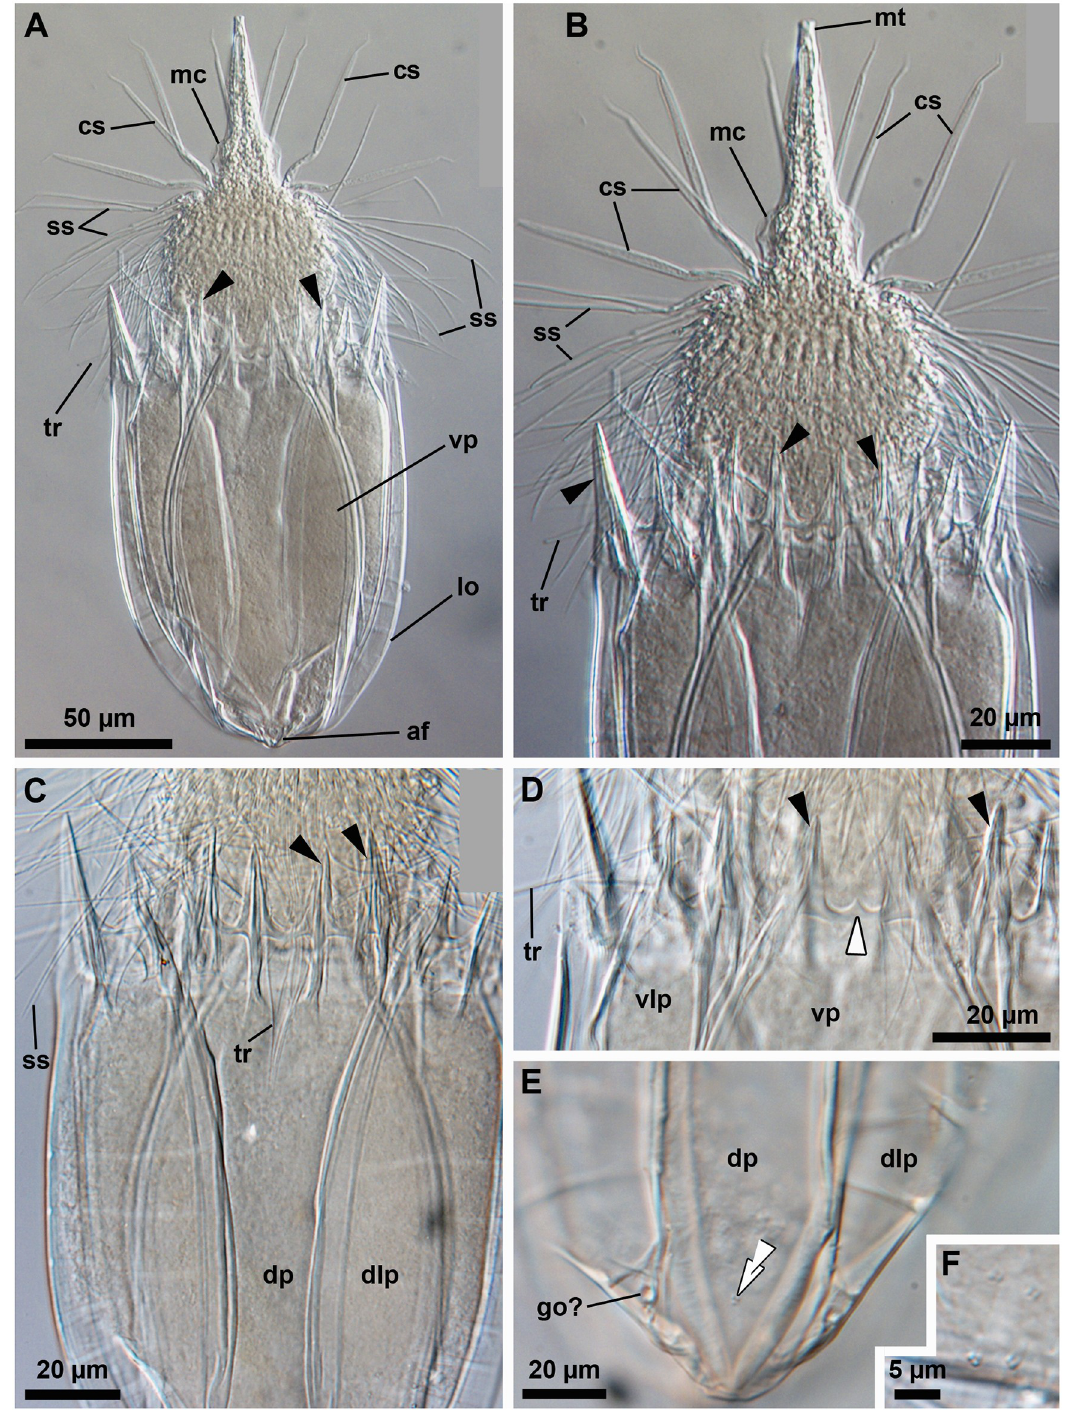
Fig 11. Light micrographs of the allotypic adult female of Nanaloricus mathildeae sp. nov. Anterior faces up in all aspects. (A) Ventral view of the extended specimen. Note that the mouth tube is not fully extended. Black arrowheads indicate anterior spikes. (B) Close-up of anterior body half, ventral view. (C) Introvert, neck and anterior region of the abdomen, dorsal view. (D) Close-up of anterior spikes of the ventral and ventrolateral plates. White arrowhead points to the very small midventral anterior spike. (E) Close up of the posterior region of the lorica, dorsal view. Note the putative gonopores (go?) located on the posteriormost region of the dorsolateral plate. Double arrowheads point to the small flosculum situated on the dorsal plate. (F) Detail of a cluster of flosculi arranged in a rectangular pattern on the right dorsolateral plate. Abbreviations: af, anal field; cs, clavoscalid; dlp, dorsolateral plate; dp, dorsal plate; lo, lorica; mc, mouth cone; mt, mouth tube; ss spinoscalid; tr, trichoscalid; vlp, ventrolateral plate; vp, ventral plate.